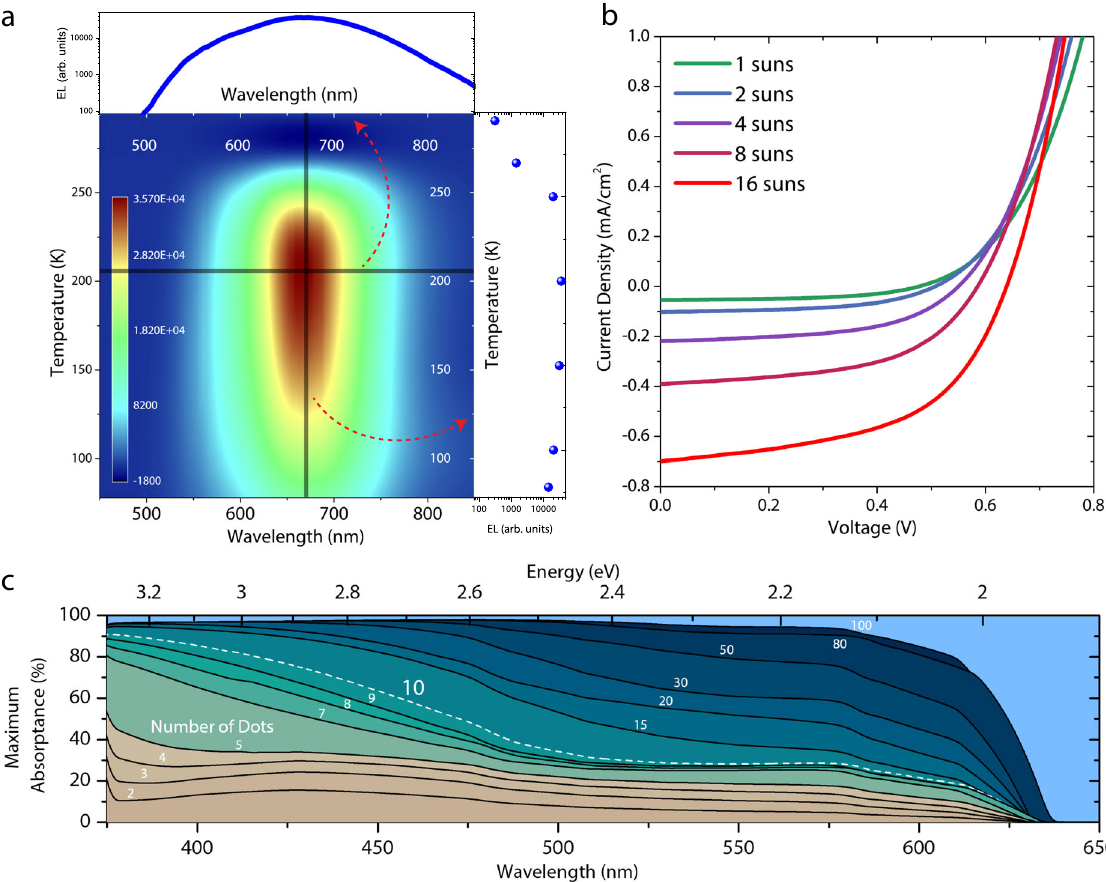
Fig. 2 Optoelectronic characterization and simulation. a Electroluminescence (EL) spectra as a function of temperature with corresponding slices through the center wavelength and temperature of maximized signal. b Current-voltage characteristics as a function of AM1.5D illumination up to 16 suns concentration. c Simulated absorptance for the valence band to intermediate band transition as a function of incident photon wavelength and number of